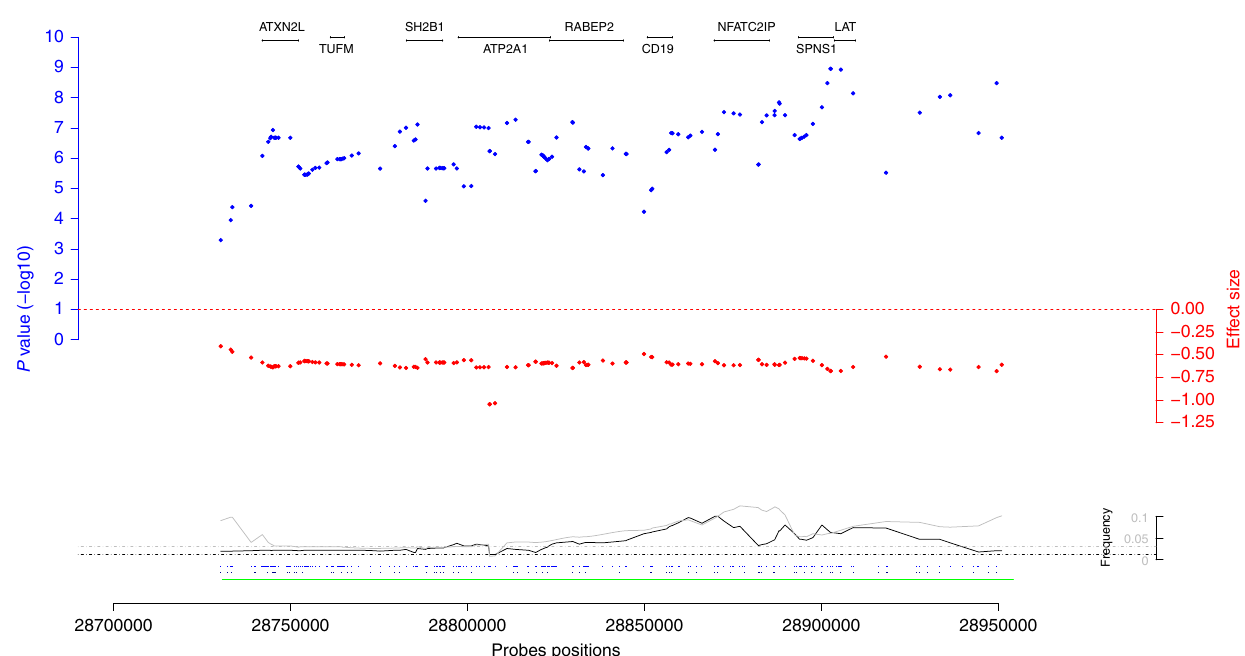
Fig. 2 Regional association plot for the 16p11.2 220 kb rearrangement. The blue dots represent − log10 BMI-association P values, the red dots show the corresponding effect sizes. At the bottom the black and gray lines are the deletion and duplication frequencies. Finally, the dots at the bottom indicate the probe positions for the GIANT cohorts ( above ) and the UK Biobank ( below ). Positions of the protein-coding genes are shown at the top of the plot. The probes positions correspond to the human genome build